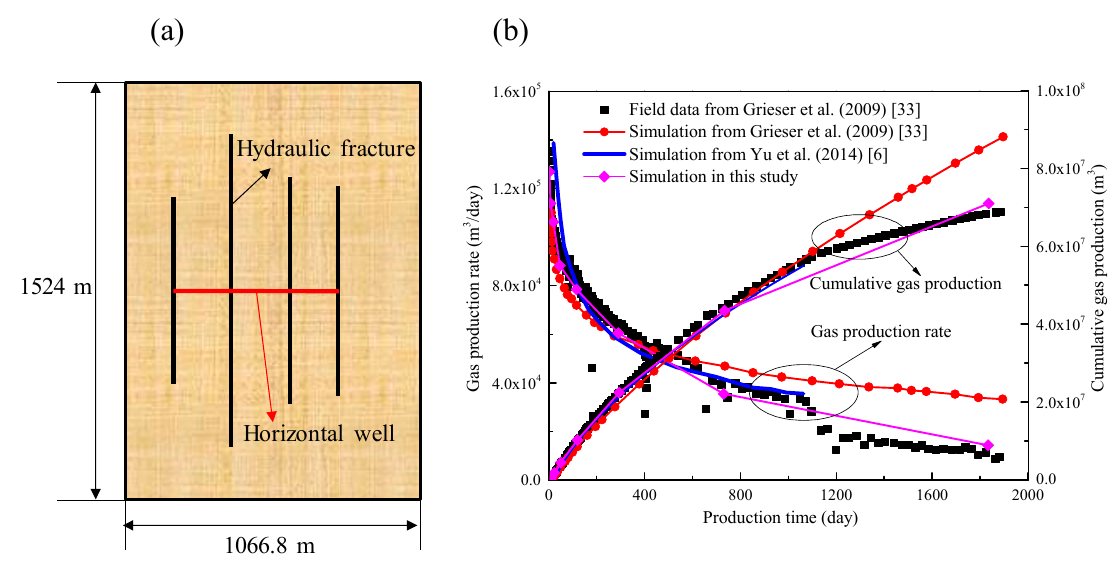
Figure 4. ( a ) Numerical model with four hydraulic fractures in the Barnett Shale and ( b ) history matching for gas production rate and accumulative gas production.